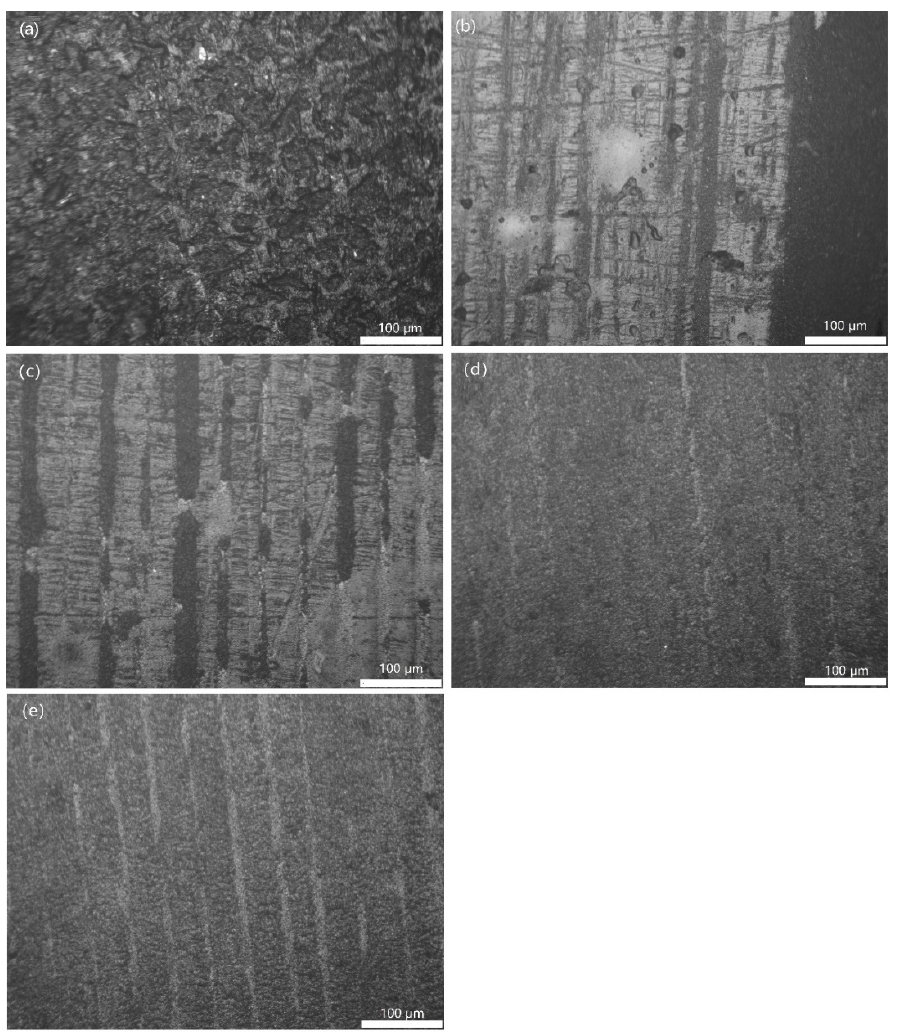
Figure 6. The wear track of the specimens under a dry friction condition. ( a ) Specimen 1; ( b ) Specimen 2; ( c ) Specimen 3; ( d ) Specimen 4; ( e ) Specimen 5.